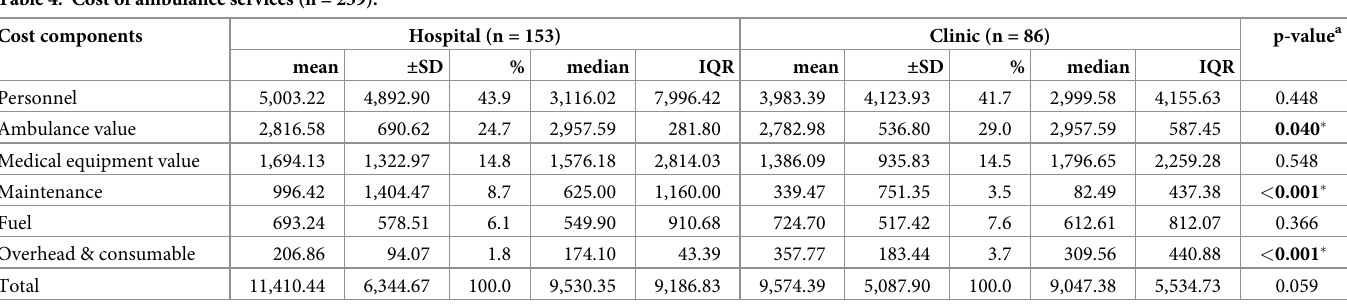
Table 4. Cost of ambulance services (n =